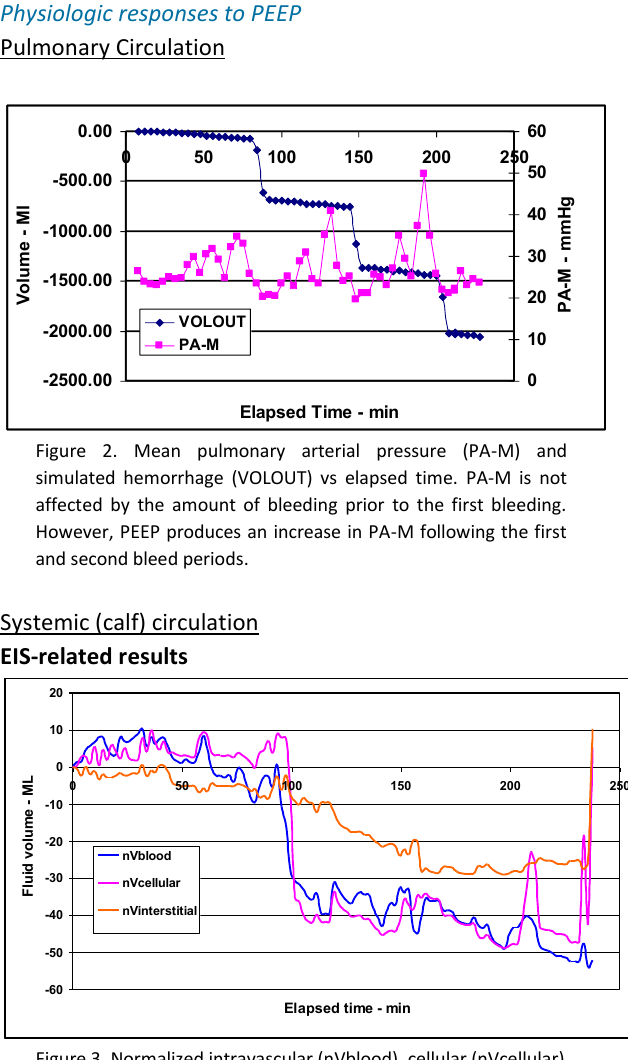
Figure 3. Normalized intravascular (nVblood), cellular (nVcellular) and interstitial (nVinterstital) calf compartment volumes vs. elapsed